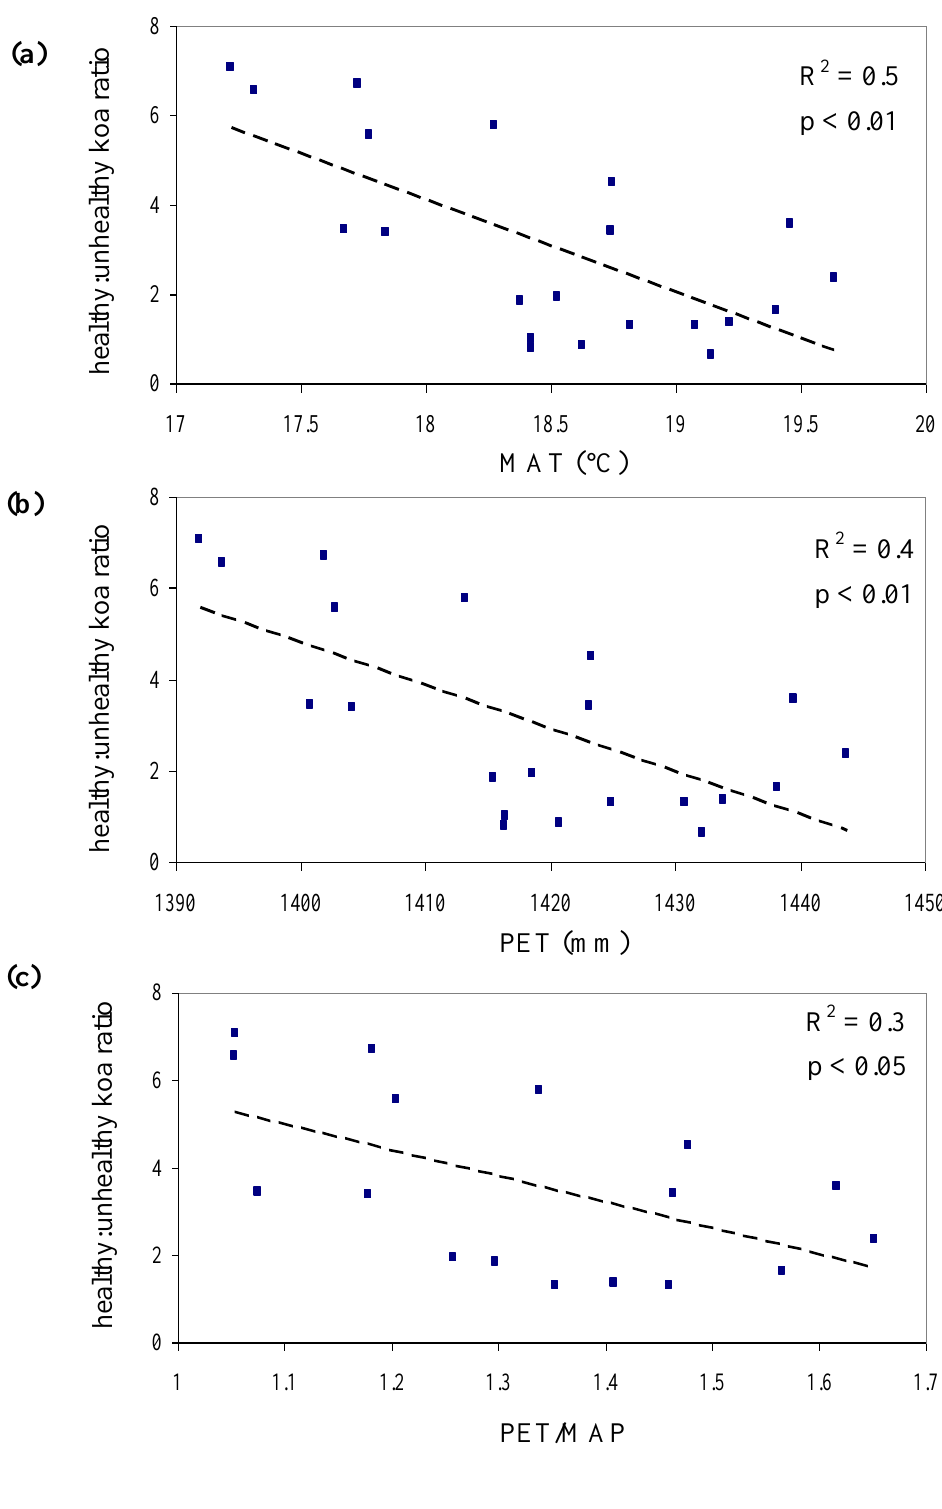
Figure 6. Relationship between healthy:unhealthy koa ratio and climatic zones of increasing temperature (a) MAT, (b) PET and (c)